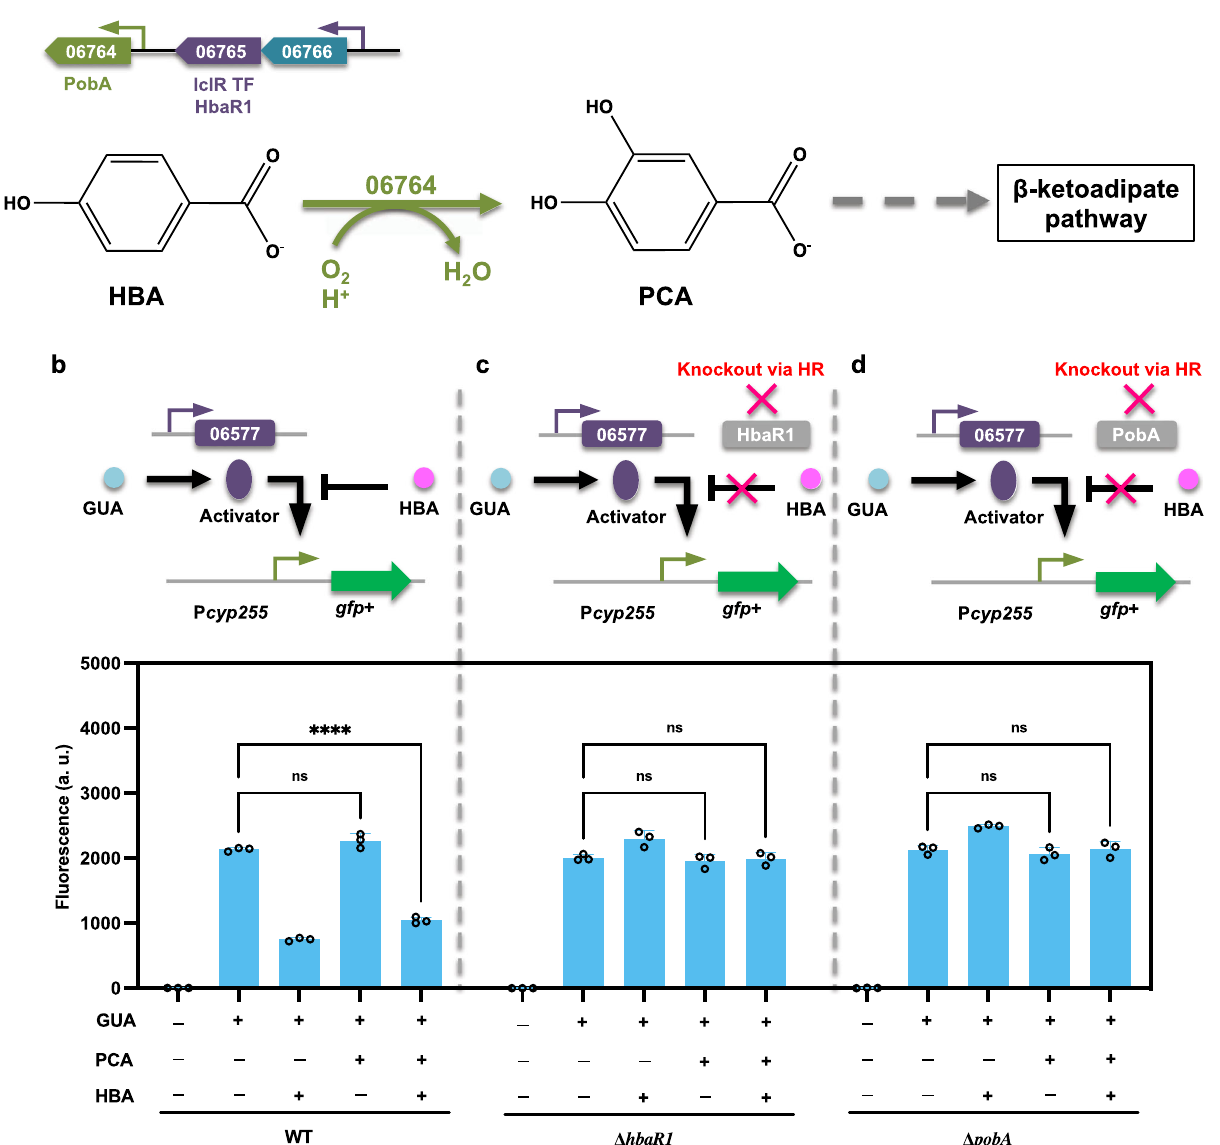
Fig. 9 Promoter activity of P cyp255 in response to guaiacol and 4-hydroxybenzoate. a Schematics depicting the funneling pathway for 4-hydroxybenzoate (HBA) and the annotated transcription factor. b – d Proposed working models for the promoter P cyp255 during growth in minimal medium with guaiacol (GUA) and HBA (upper) and fl uorescence of P cyp255 -GFP + in response to GUA and HBA in WT and knockout strain backgrounds (lower). All cultures contained 1 g/L glucose with either 0.3 g/L GUA, or 0.3 g/L GUA plus 0.9 g/L protocatechuic acid (PCA) or 0.9 g/L HBA. The concentrations of the PCA and HBA mixtures were set at 0.45 g/L. All the fl uorescence values were determined in the early stationary phase and normalized to OD 600 . Unpaired two-tailed t test was used to compare variations in the changes of fl uorescence of the two aromatic mixtures against that of the GUA-only control (****, P < 0.0001; ns, not signi fi cant). All values represent the mean of triplicate cultures, with error bars depicting the standard deviation from that